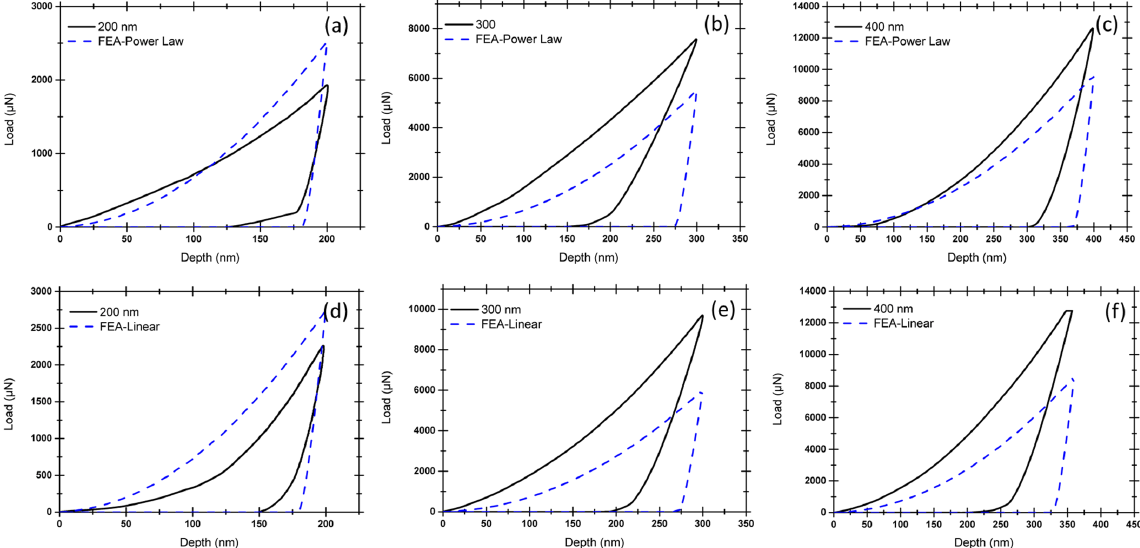
Figure 6. Comparison between the experimental and simulated load vs. displacement curves for the RD and TD of Cu(16)/Nb(16) ARB nanolaminate. The indention depths were ( a ) 200 nm, ( b ) 300 nm and ( c ) 400 nm for RD and ( d ) 200 nm, ( e ) 300 nm and ( f ) 400 nm for TD Cu(16)/Nb(16) ARB nanolaminate.